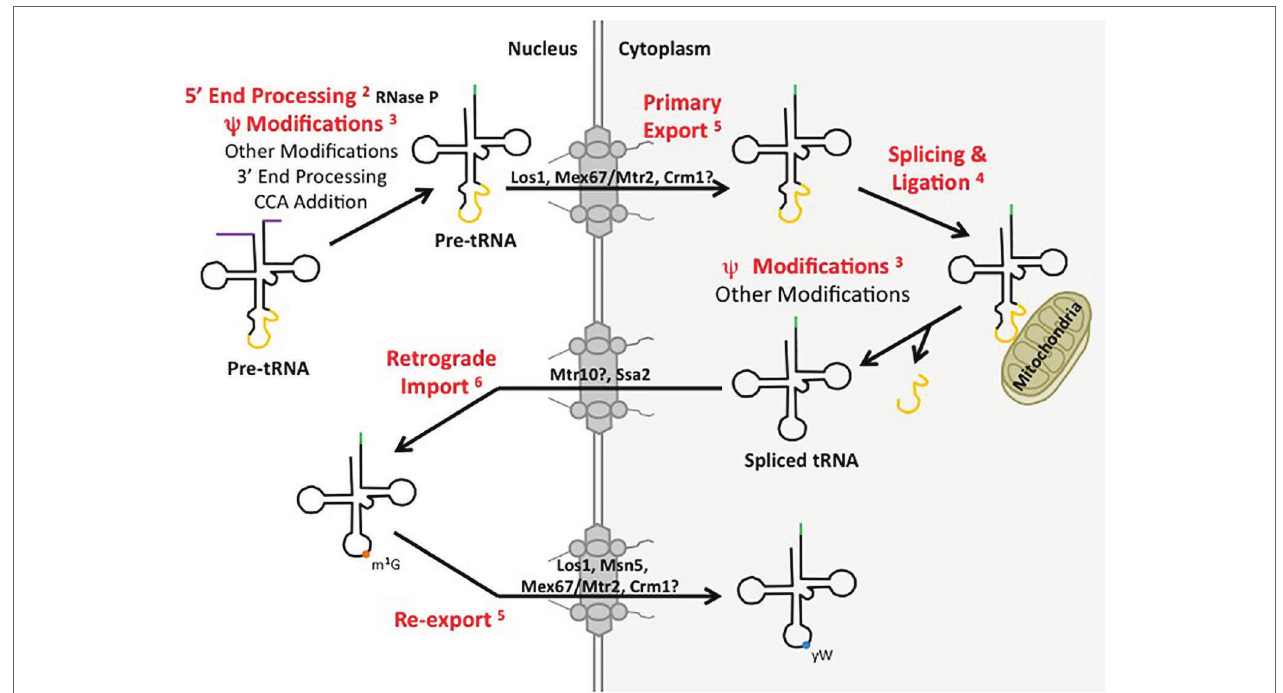
FIGURE 1 | tRNA biogenesis and subcellular trafficking steps multitask in the processing/localization of other RNAs. Yeast tRNAs are synthesized as primary tRNAs (pre-tRNA) in the nucleolus and undergo subsequent 5 ′ and 3 ′ end processing, modifications (such as pseudouridine modification) and CCA addition, generating pre-tRNAs. These pre-tRNAs are then exported from the nucleus to the cytoplasm (shaded white and grey, respectively) via Los1, Mex67-Mtr2, or potentially Crm1 in a step termed tRNA primary nuclear export. tRNAs containing an intron are then spliced at the surface of the mitochondria by the SEN complex and the two tRNA halves are ligated by Rlg1/Trl1. Further nucleoside modifications also take place in the cytoplasm. Spliced tRNAs undergo a second trafficking step termed retrograde nuclear import, mediated by Ssa2 and potentially Mtr10. Once back in the nucleus, spliced tRNAs can be modified by enzymes that only recognize spliced tRNAs, and not intron-containing tRNAs, such as Trm5-catalyzed methylation of G at position 37 (m 1 G 37 ; orange circle). tRNAs are then re-exported from the nucleus to the cytoplasm by any of the primary exporters or Msn5, which functions solely in the re-export step, to be utilized in translation. Certain tRNAs receive additional modifications, such as modification of the m 1 G 37 to wybutosine (yW; blue circle) in tRNA Phe in yeast. The tRNA biogenesis and subcellular trafficking steps highlighted in red indicate pathways utilized by not only tRNA, but other RNA species as well. Each is discussed in the text and the appropriate figure numbers are indicated in